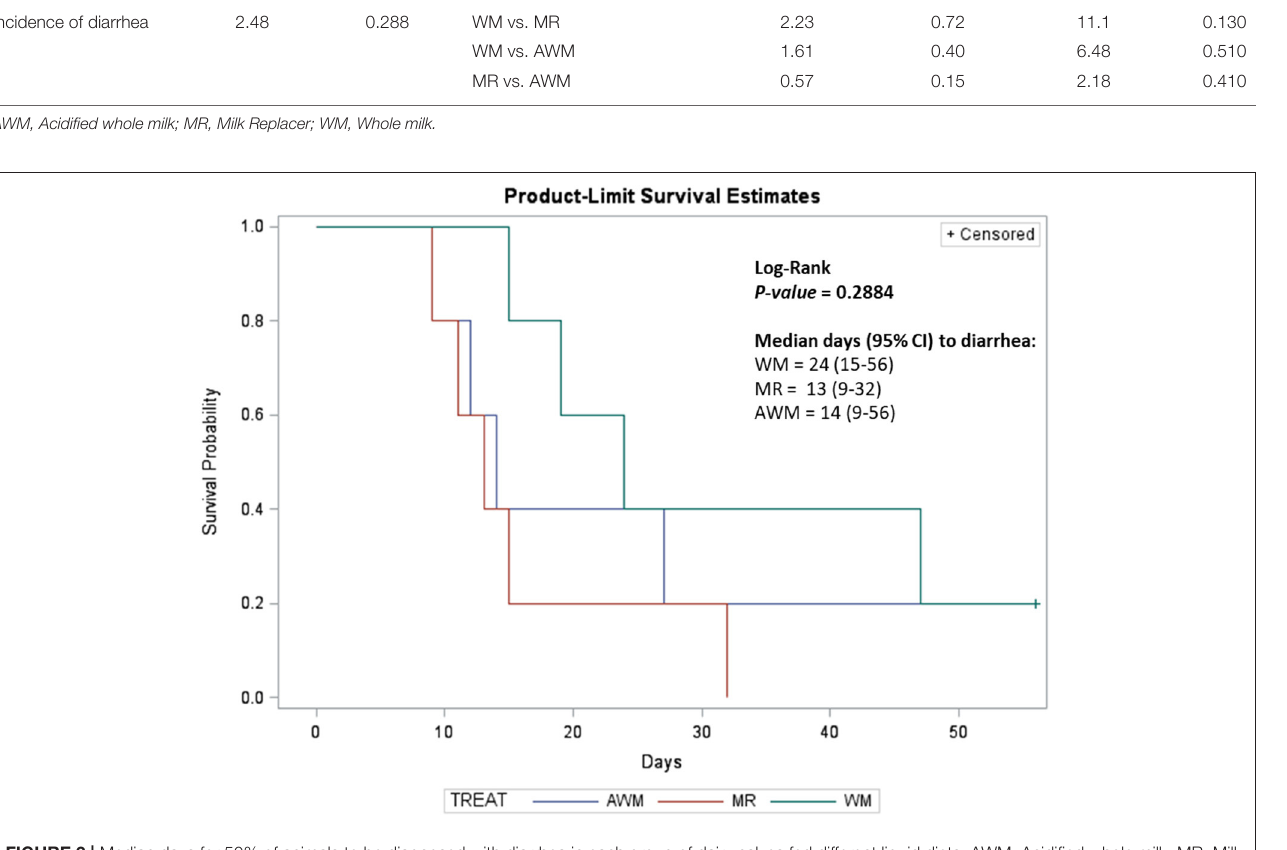
FIGURE 2 | Median days for 50% of animals to be diagnosed with diarrhea in each group of dairy calves fed different liquid diets. AWM, Acidified whole milk; MR, Milk replacer; WM, Whole Milk.